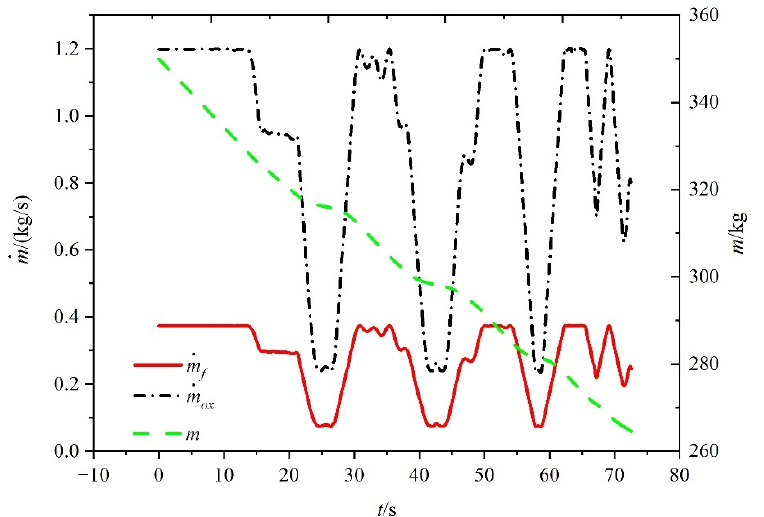
Figure 20. Propellant mass flow rates and vehicle mass under case 2 in the third scenario vs. time. Table 5. Comparison of results for the three flight scenarios.